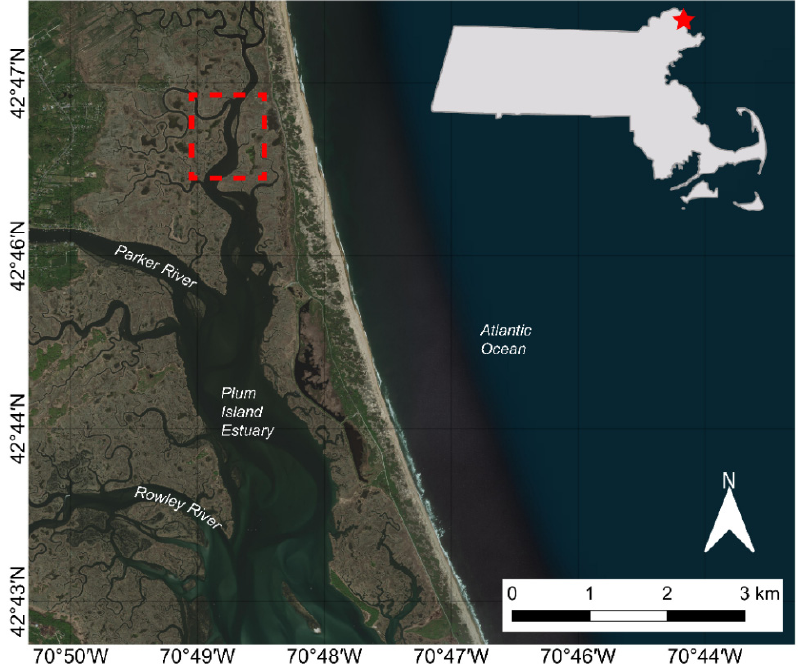
Figure 1. Plum Island Estuary (PIE) in Massachusetts, USA; the boundaries of the study site are in red. ESRI image collected on 12 October 2021.